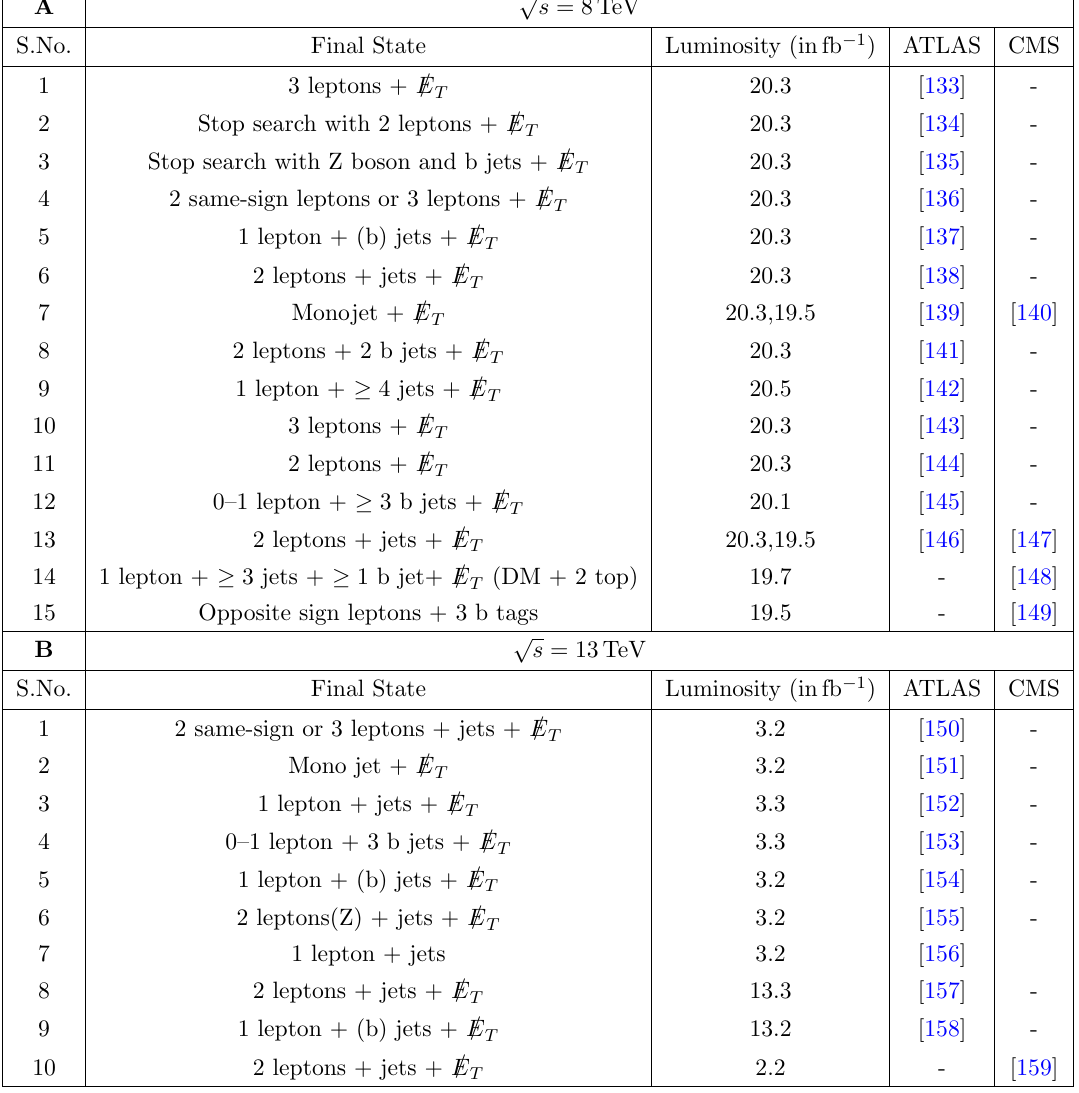
Table 2 . List of LHC analyses at s = 8,13 TeV implemented in the public software CheckMATE. All the benchmarks considered in our study pass these analyses, without showing any excess above the observed number of events at 95%